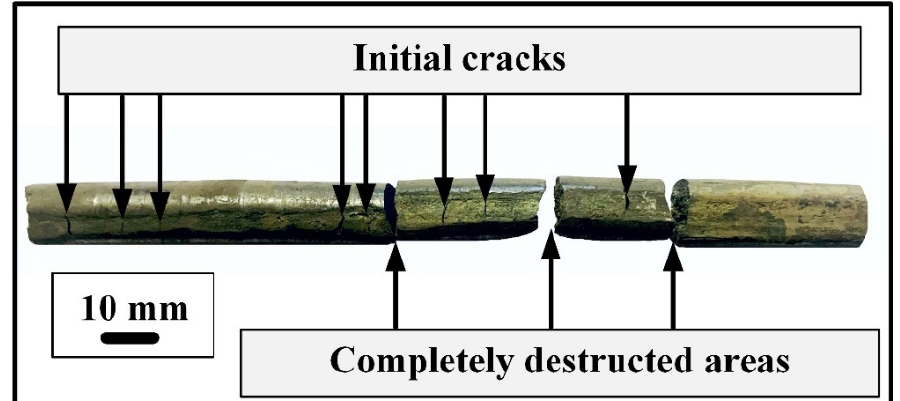
Figure 2. Image of TiNiHf sample with 3.0 at.% Hf after several passes of rotary forging.